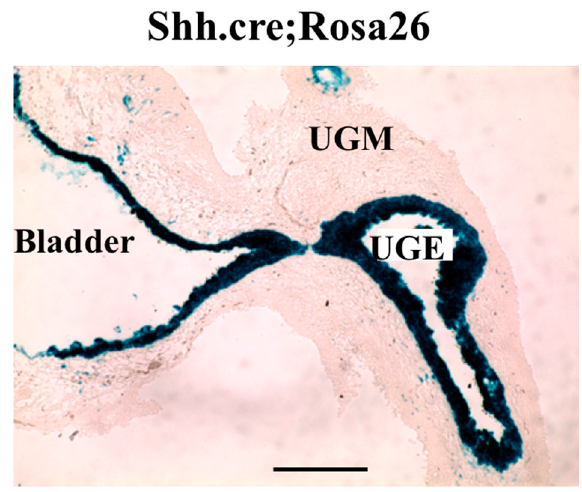
Figure 3. Staining for beta-gal in E16 UGS of Shh cre ;Rosa26R mice. Note efficient recombination through the UGS epithelium (UGE) and bladder epithelium. UGM: UGS mesenchyme; n = 3.